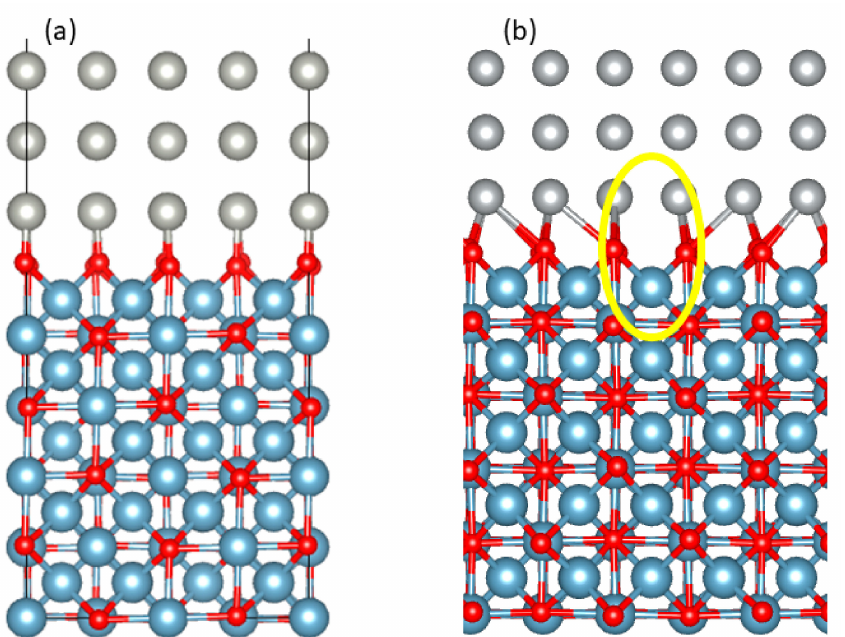
Figure 3. ( a ) Pd/alumina interface showing close lattice match. ( b ) Ni/alumina interface with lattice-mismatch defect circled in yellow. (O = red, Al = blue, Pd or Ni = silver/gray) Structures not optimized. Image by VESTA